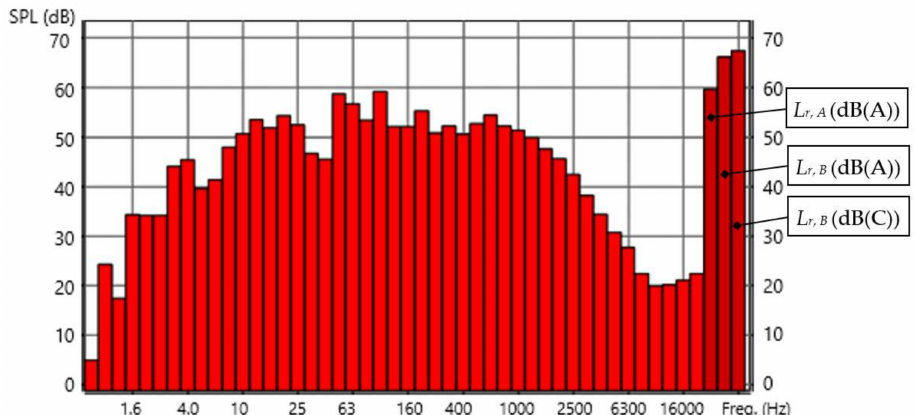
Figure 9. Diagram of the sound pressure levels in the range of the middle frequencies of the one-third octave bands from 20 Hz to 20 kHz at the point of reception behind the barrier and the single-number rating of sound insulation at the point of reception: with a barrier L r,A in dB(A), without a barrier L r,B in dB(A), and without a barrier L r,B in dB(C).